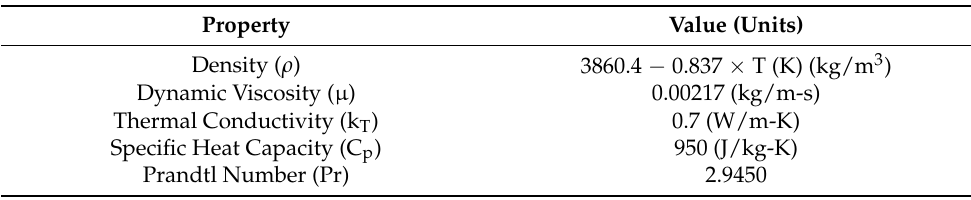
Table 3. UCl 3 -NaCl fuel-salt properties